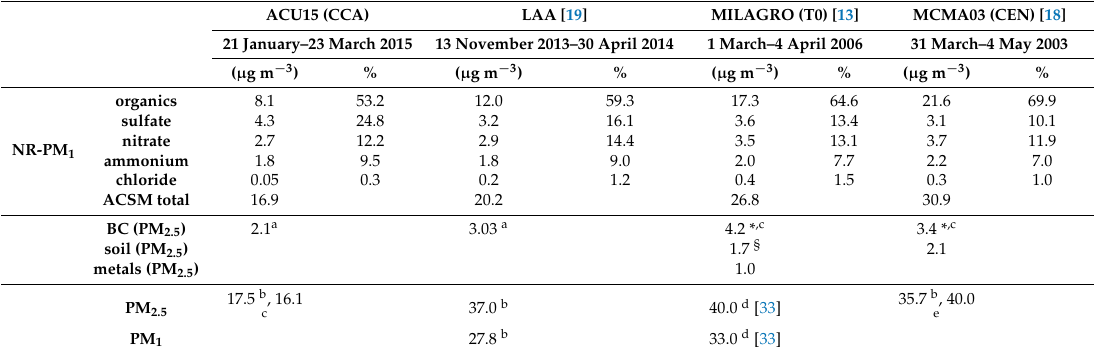
Table 1. Summary of PM data during ACU15 and previous studies in Mexico City involving an